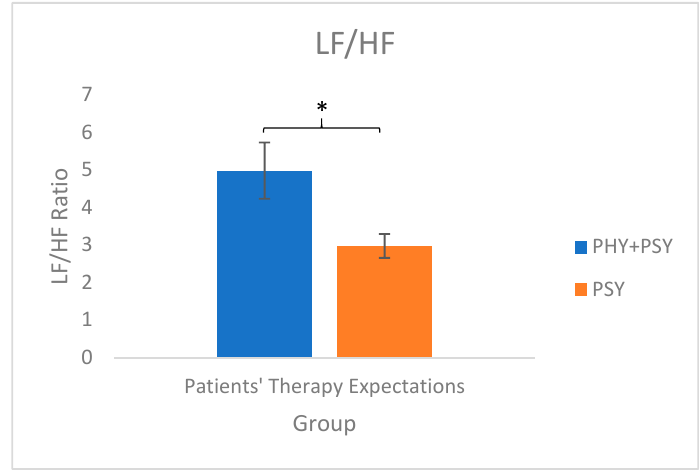
Figure 2. E ff ect of EAT on the LF / HF ratio: e ff ect of patients’ therapy expectations. Mean ± standard Figure 2. Effect of EAT on the LF/HF ratio: effect of patients’ therapy expectations. Mean ± standard error. * p < error. * p < 0.05.